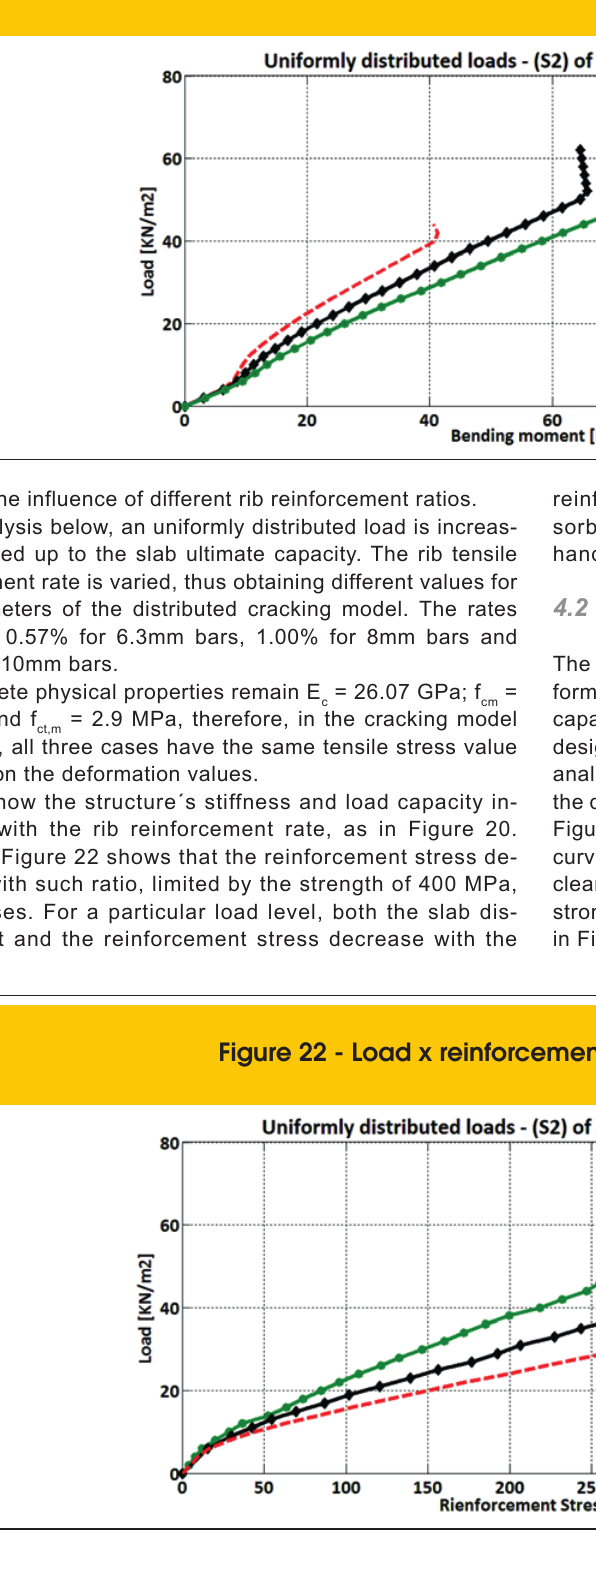
Figure 21 – Load x bending moment in section - S2